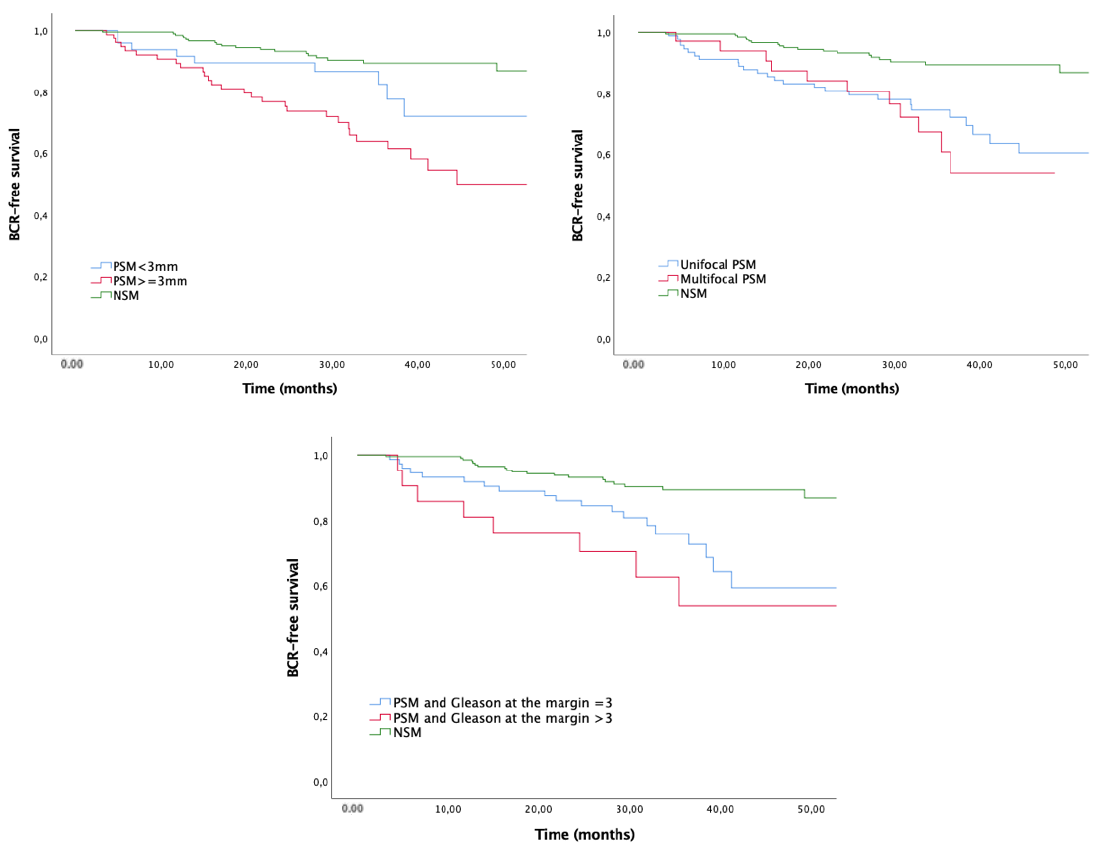
Figure 2. Kaplan–Meier curves for biochemical recurrence stratified by margin’s characteristics. Log-rank p < 0.001.